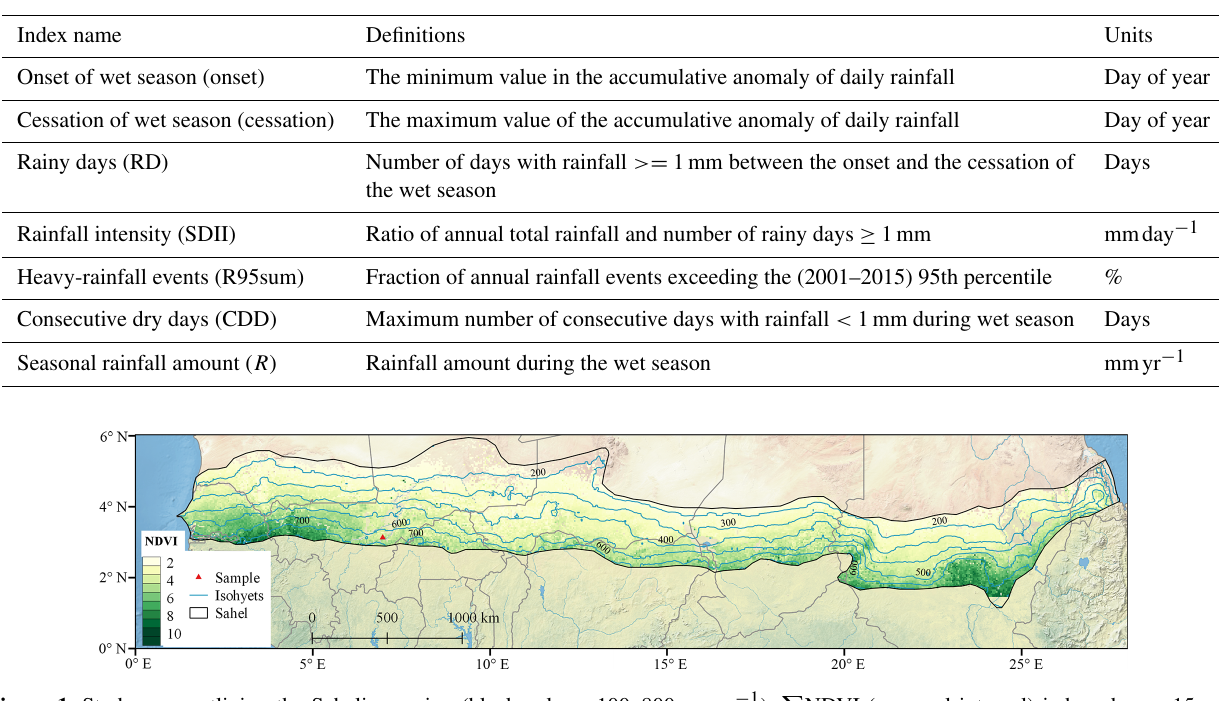
Figure 1. Study area outlining the Sahelian region (black colour; 100–800mmyr − 1 ). P NDVI (seasonal integral) is based on a 15-year (2001–2015) average using MODIS data; the red grid point (13.5 ◦ N, 5.0 ◦ W) is used to illustrate the extractions of onset and cessation